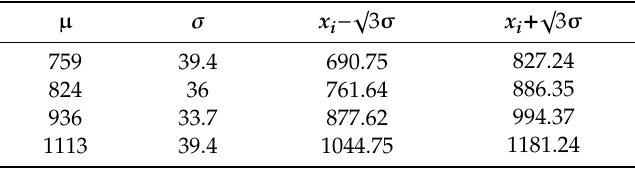
Table 1. Quadrature Gaussian sampling: Flow rate values are in m 3